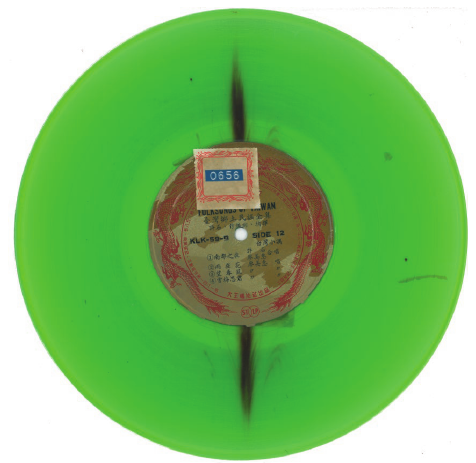
Fig. 1 “Taiwan Melody” in Air Hostess (1959) is a Mandarin cover of the first major hit of postwar Taiwan, a “folk” love song entitled “Night in a Southern City” / “Night in the City of Tainan” 南都之夜 (1946) composed by Hsu Shih 許石 . “Night in a Southern City” appears on “Folksongs of Taiwan,” King Records KLK-59-B, c. 1962-64. ©